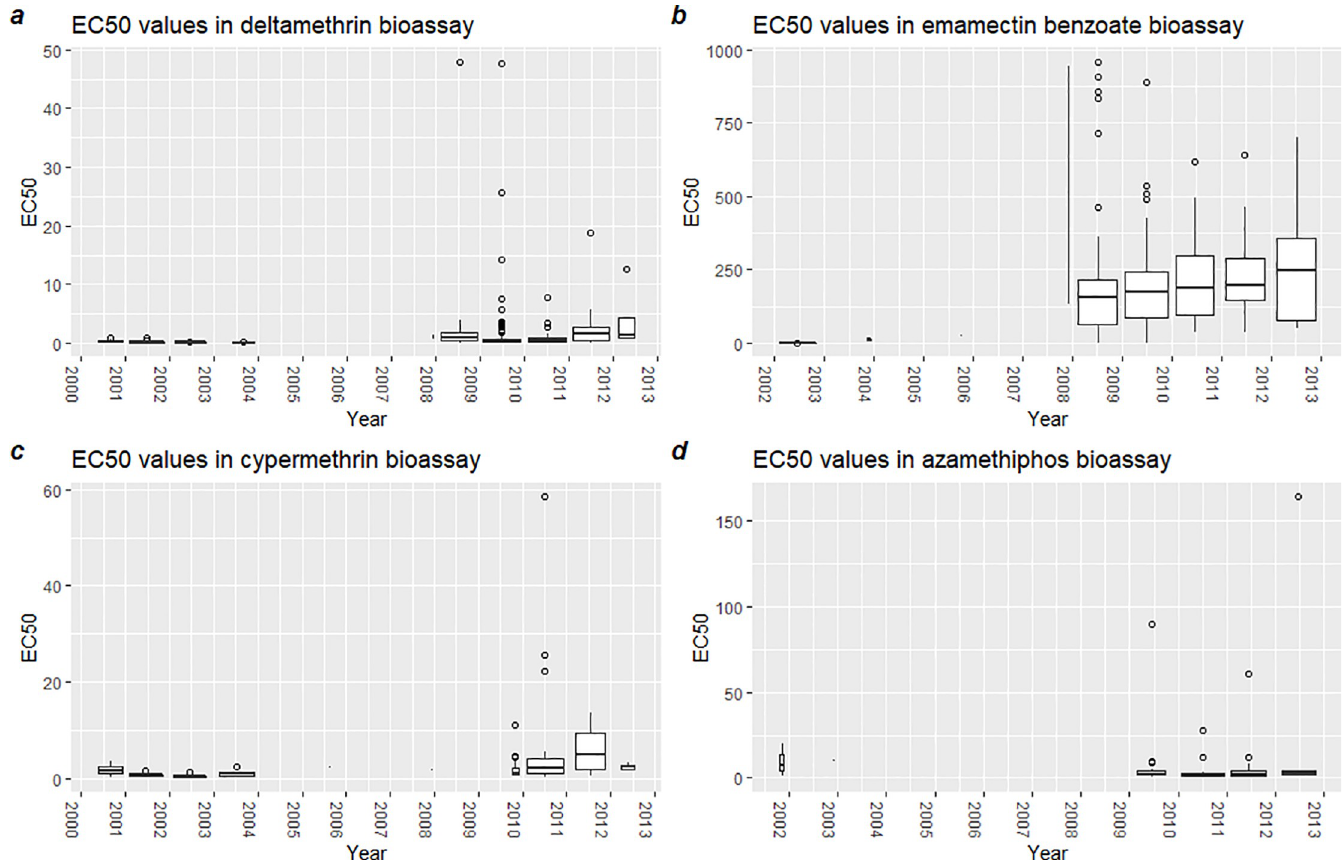
Fig 2. Predicted EC 50 values in bioassays run in years 2000–2012.